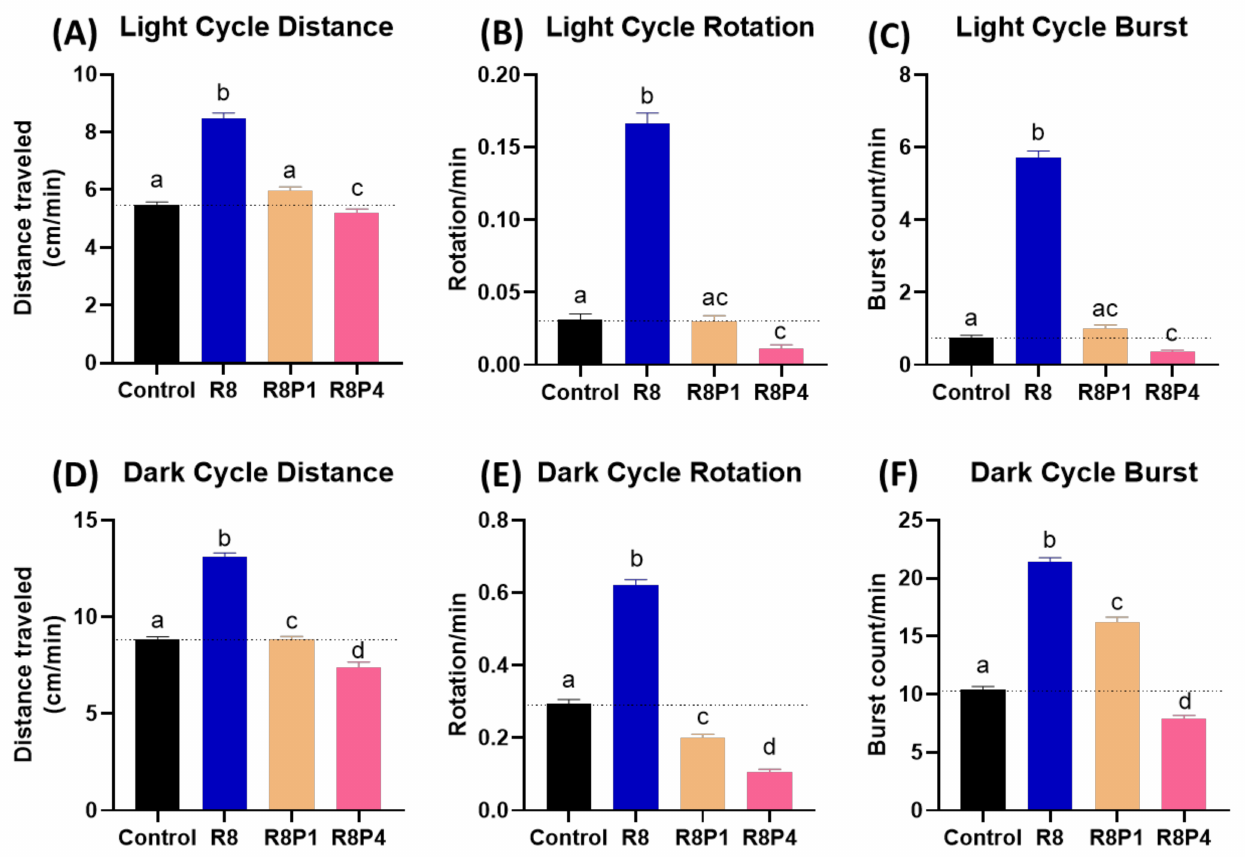
Figure 7. Locomotory activity evaluation after co-incubation of different doses of RAC and PROP in zebrafish larvae after 24-h incubation. Totally, six endpoints of ( A ) Light cycle distance, ( B ) Dark cycle distance, ( C ) Light cycle rotation, ( D ) Dark cycle rotation, ( E ) Light cycle burst, and ( F ) Dark cycle burst were measured and compared. The statistics were demonstrated as the mean ± SEM and analyzed by Kruskal–Wallis test followed with Dunn’s multiple comparisons test. Different letters a, b, c, and d above columns indicate significant statistical differences with p < 0.05 ( n = 48). Abbreviations: R8 (RAC 8 ppm), R8P1 (RAC 8 ppm and PROP 1 ppm), and R8P4 (RAC 8 ppm and PROP 4 ppm). Black bar: control, blue bar: R8, cream bar: R8P1, and pink bar: